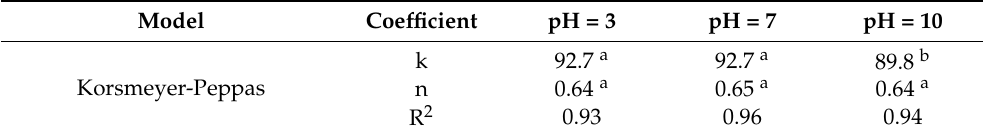
Table 2. Coefficients of the Korsmeyer-Peppas mathematical model obtained from the controlled release of the biodefensive